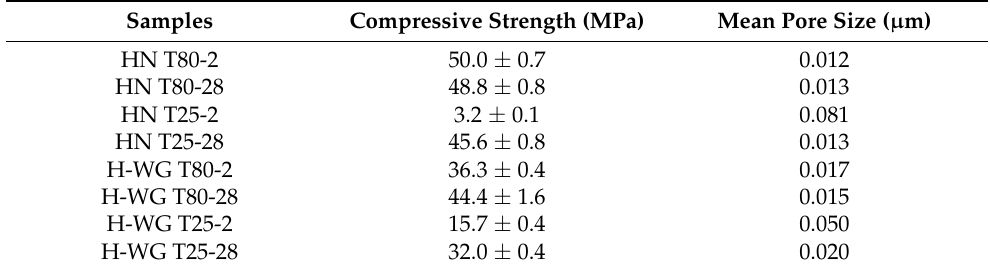
Table 5. Hybrid cement paste compressive strength (MPa) and mean pore size ( µ